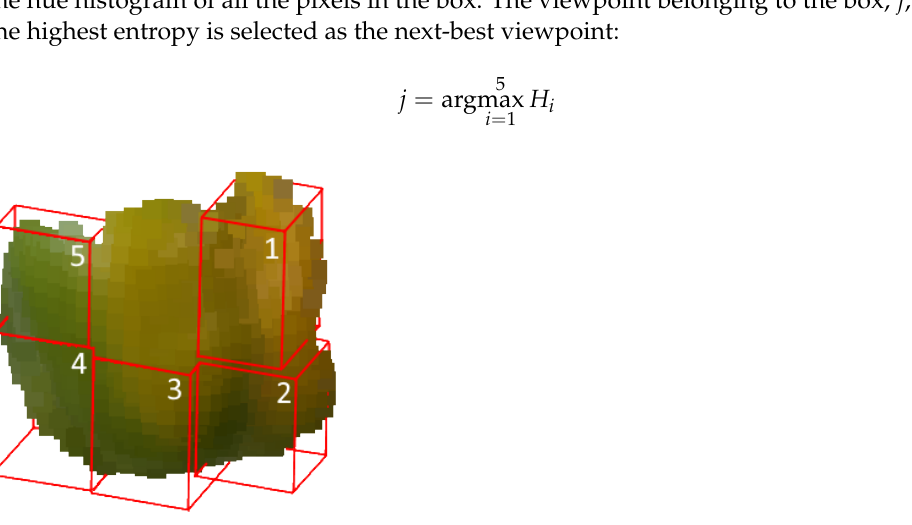
Figure 7. Point cloud from an initial viewpoint of a sweet pepper indicating the five boxes that have a corresponding next-viewpoint. The number corresponds to the next-viewpoint